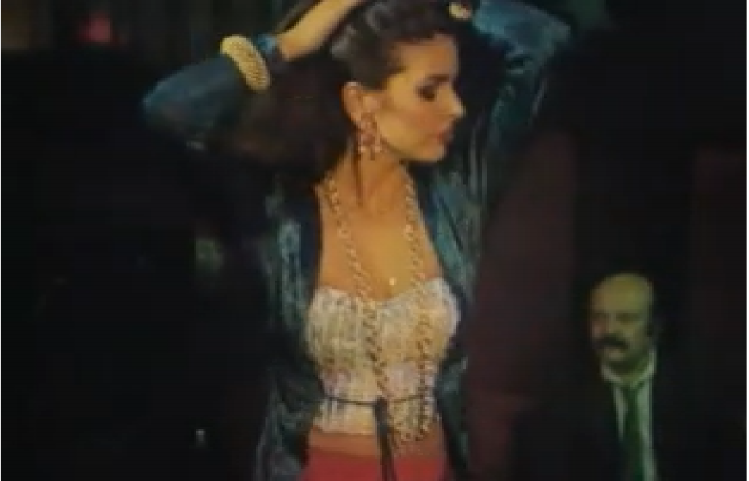
Figure 7: Serap (Derya Arbaş) dances for the